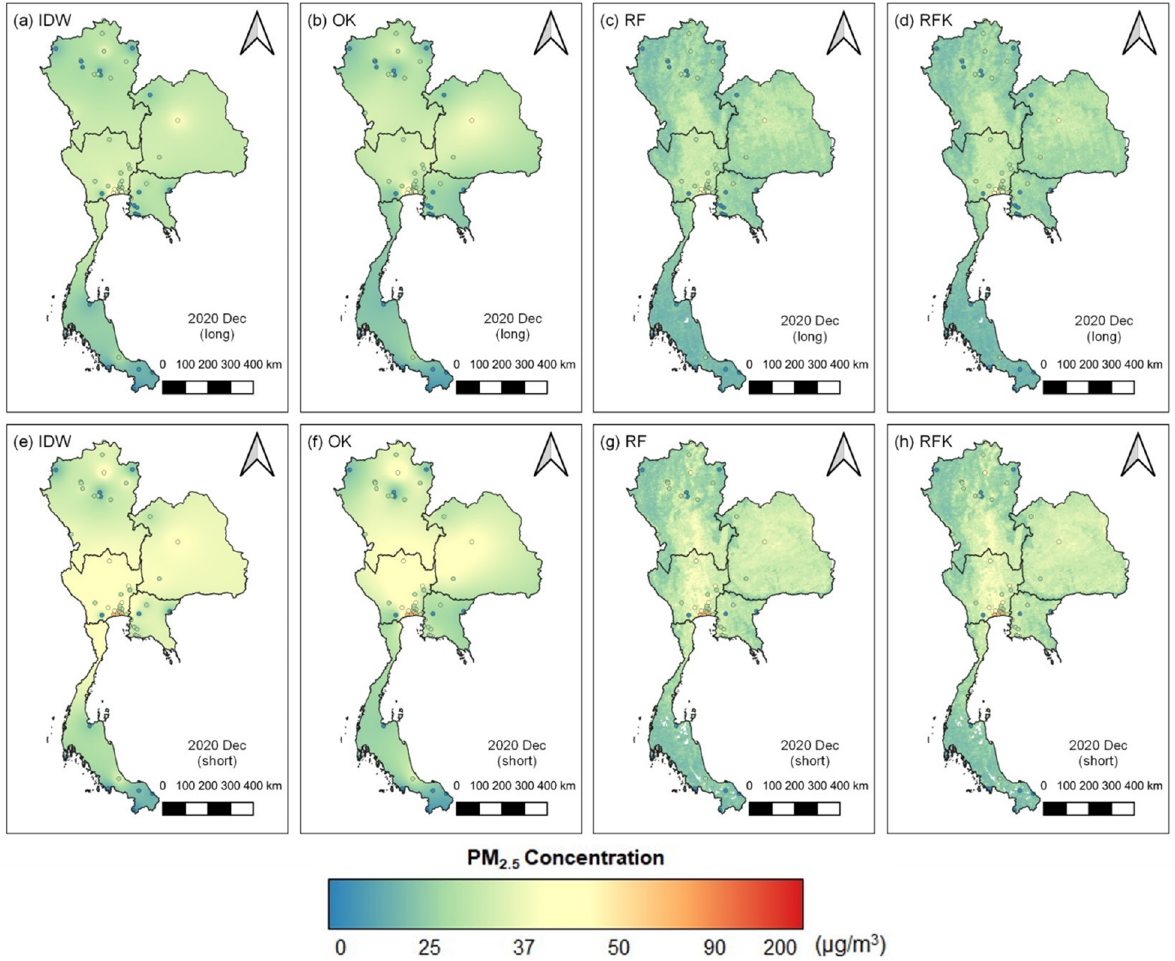
Figure 7. Interpolated PM 2.5 concentrations from different spatial interpolation methods ( a – d ) from 1 to 31 December and ( e – h ) from 5 to 15 December.